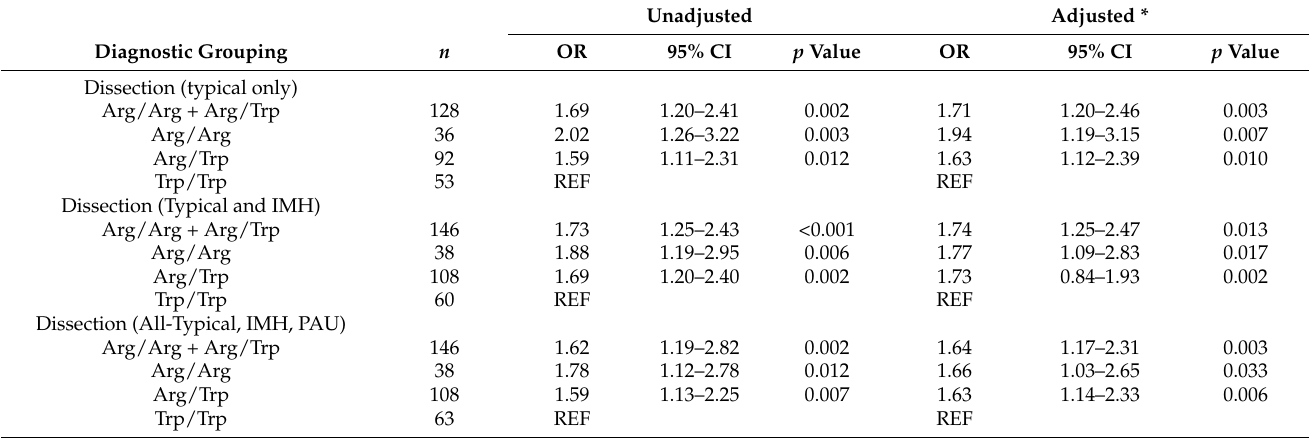
Table 4. Association of KIF6 719Arg genotype with thoracic aortic dissection categories. (See Reference 19 for detailed discussion of typical and variant (IMH/PAU) dissection pathologies.).